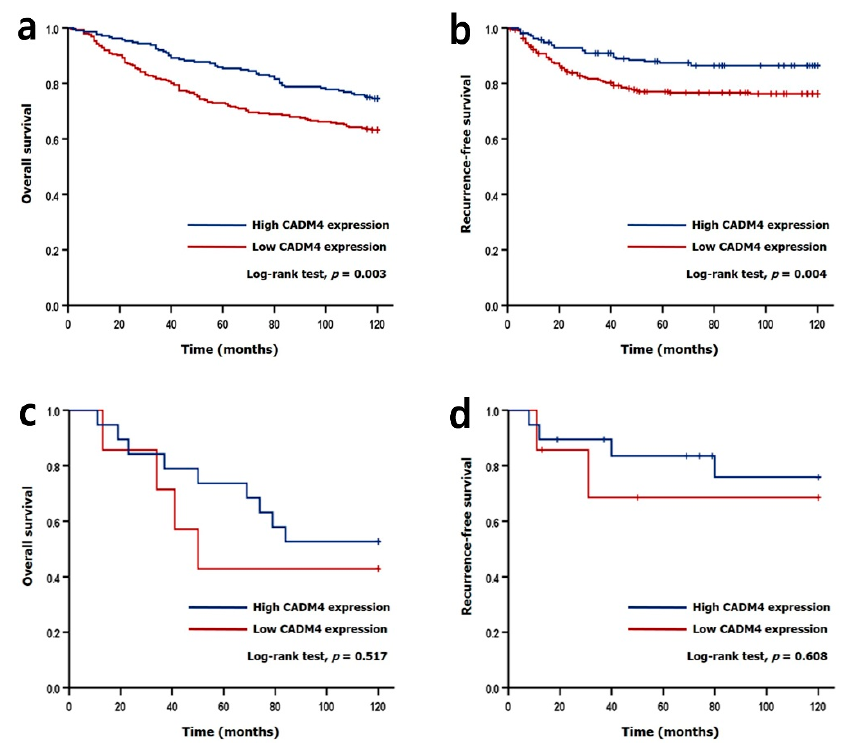
Figure 3. Kaplan–Meier analyses in the HER2-negative group ( a , b ) and the HER2-positive group ( c , d ). Overall survival and recurrence-free survival were significantly worse in patients with low CADM4 expression in the HER2-negative group (Log-rank test, p = 0.003 and p = 0.004, respectively). In the HER2-positive group, there was no significant difference in overall survival or recurrence-free survival according to CADM4 expression.